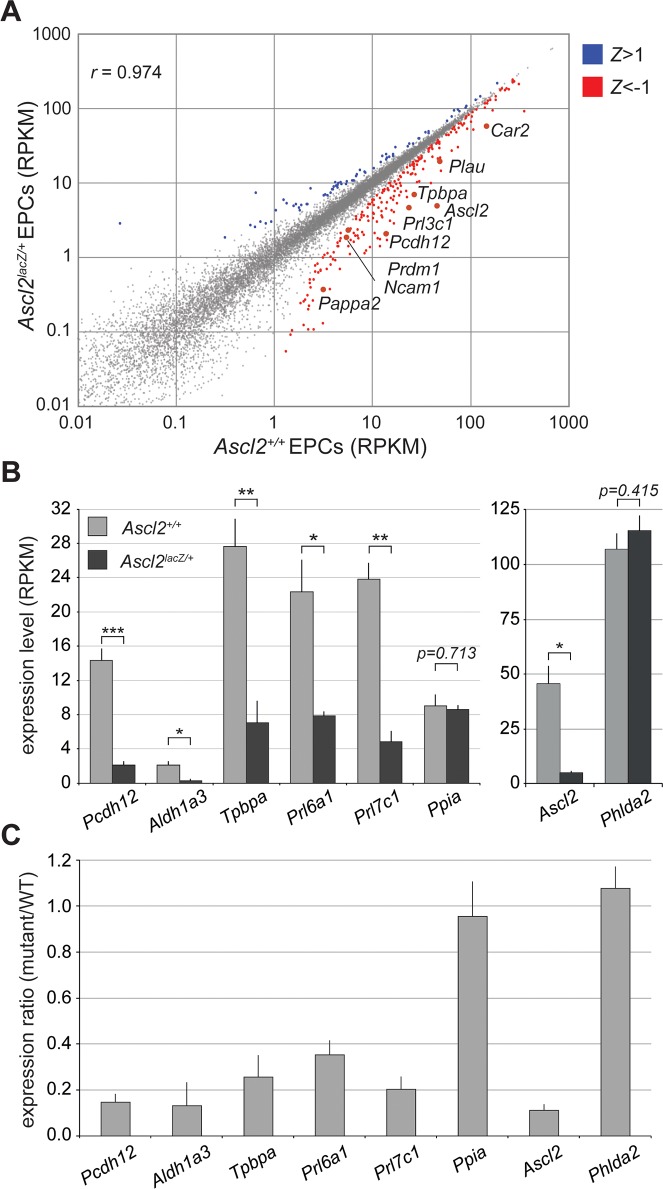
RNA-seq analysis of wild-type and Ascl2-deficient E7.5 ectoplacental cones.(A) Scatter plot showing average RPKM values for 25,071 autosomal RefSeq genes, from the RNA-seq analysis of dissected E7.5 EPCs from three wild-type (Ascl2+/+) and three mutant (Ascl2lacZ/+) littermates. Significantly upregulated genes (72 genes, Z > 1) and downregulated genes (217 genes, Z < −1) are shown in blue and red, respectively. r: Pearson correlation coefficient. (B) Average RPKM values for selected genes known to be expressed in spongiotrophoblast and glycogen trophoblast derivatives of EPC progenitors, from the RNA-seq analysis of E7.5 EPCs of given genotypes. Ppia is included as a housekeeping gene control. * p<0.05; ** p<0.01; *** p<0.005. (C) Fold change in RPKM values (mutant/wild-type) for the genes analyzed in B. Graphs show average and SD for three biological replicates per genotype.